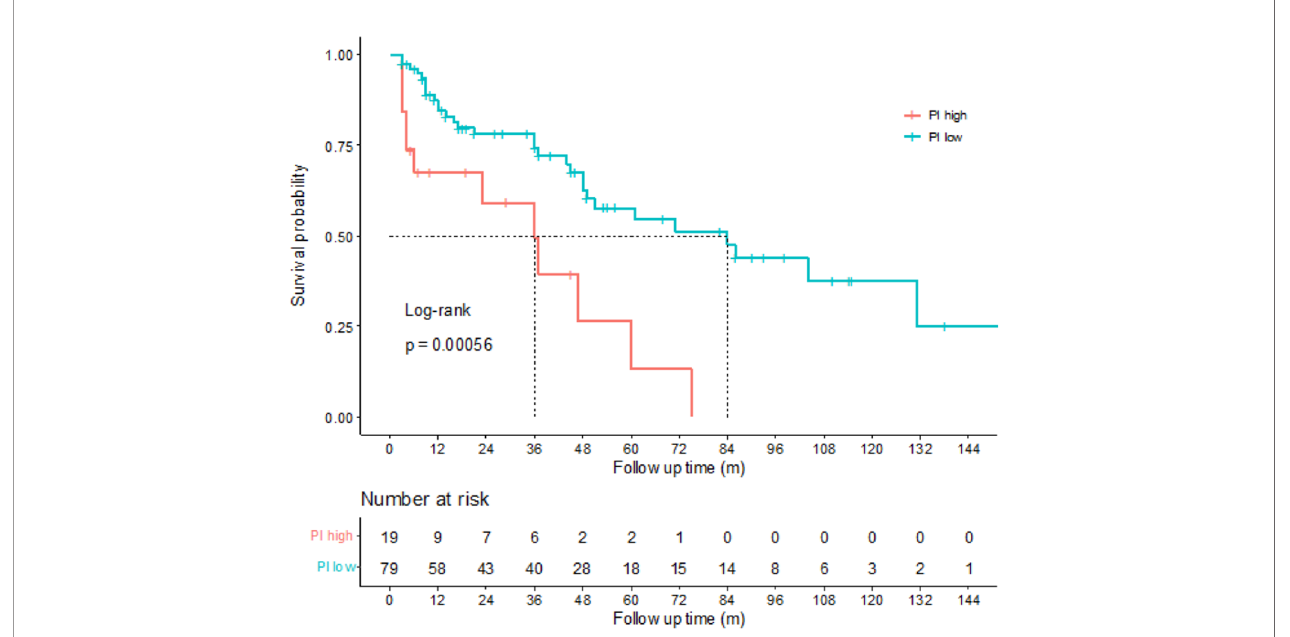
FIGURE 5 | Correlations between disease-free survival (DFS) and prognostic index (PI) of high risk non-muscle-invasive bladder cancer (NMIBC) patients. Kaplan-Meier curves revealed that the high risk NMIBC patients with high PIs tended to have poorer DFS than the high risk NMIBC patients with low PIs (log-rank test,